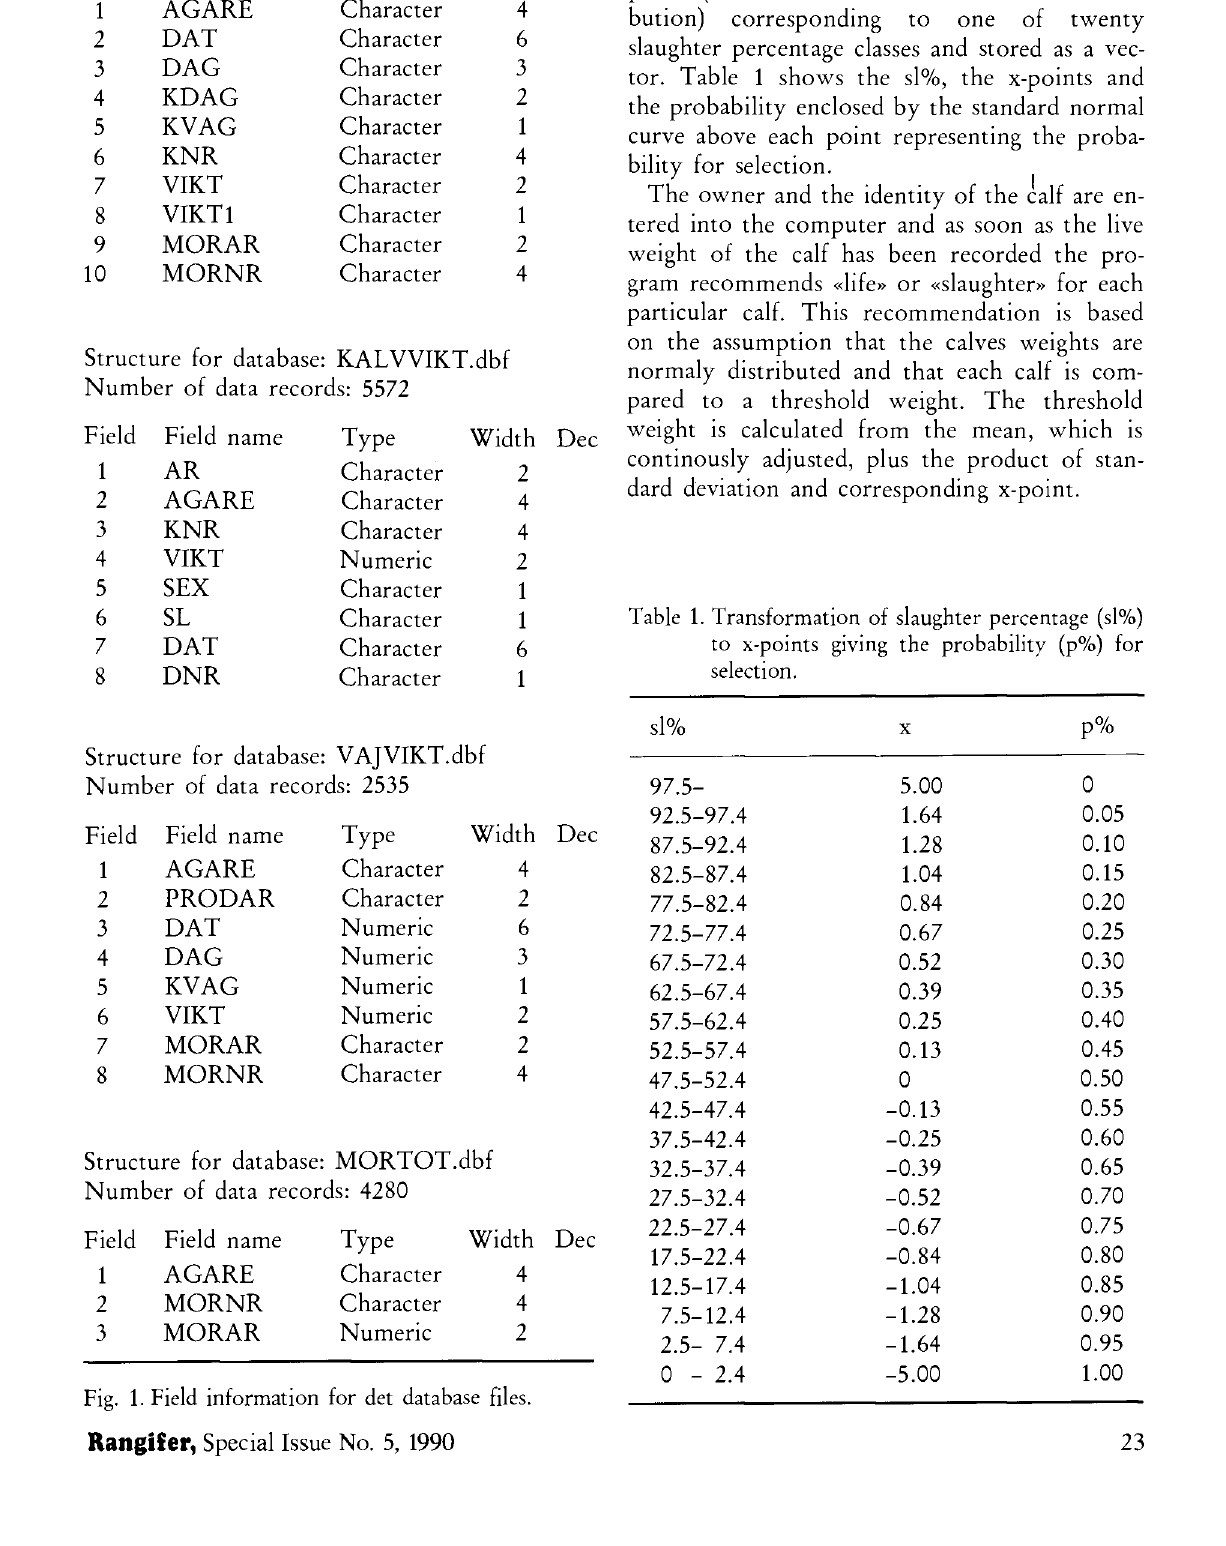
Fig. 1. Field information for det database